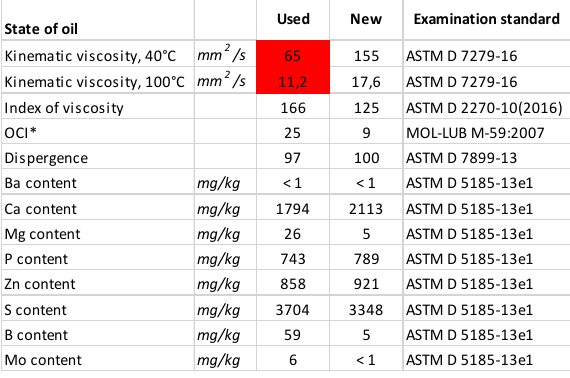
Figure 10: Table showing the comparison of the state of oils Examination parameters in the 1 st column, units are in the 2 nd , values belonging to the 1000 km ran, used oil are in the 3 rd column and values belonging to the new oil are in the 4 th